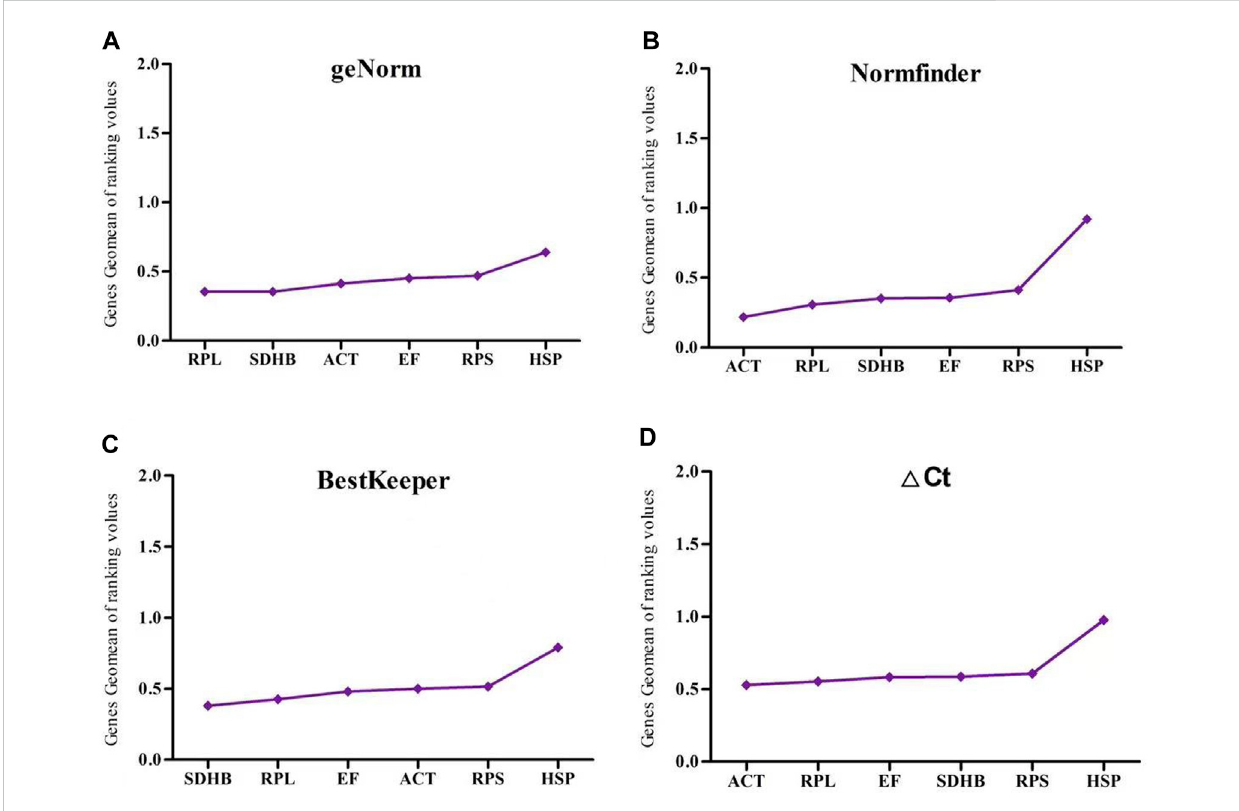
FIGURE 6 The stability of six reference gene different light treatment samples of Megalurothrips usitatus genescalculated by the Geomean method of RefFinder. (A) , geNorm; (B) , NormFinder; (C) , BestKeeper; (D) , Δ Ct.